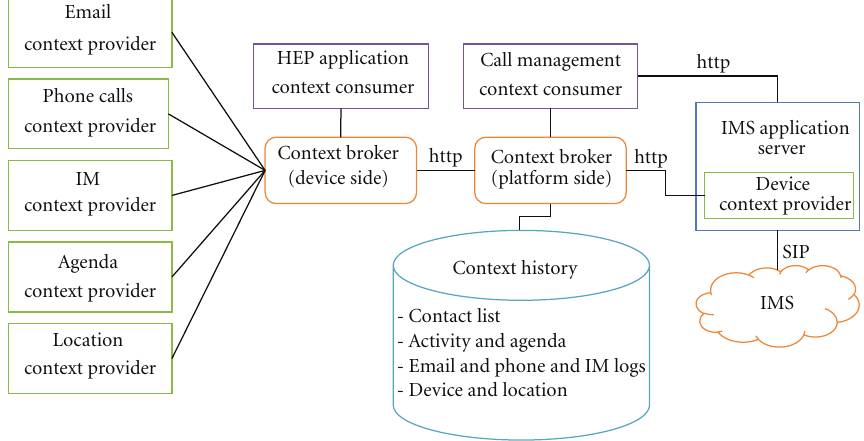
Figure 4: Architecture of the call management